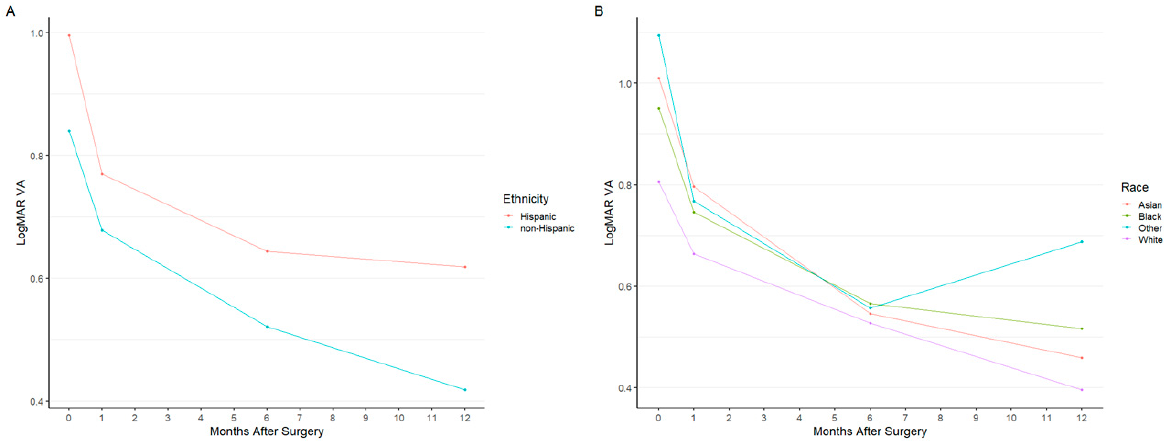
Figure 5. Mean logMAR visual acuity by ( A ) ethnicity (Hispanic or non-Hispanic) and ( B ) race (Asian, Black, White, or Other). The four time points indicated are the preoperative visit (month 0), 1-month postoperative visit, 6-month postoperative visit, and 12-month postoperative visit.